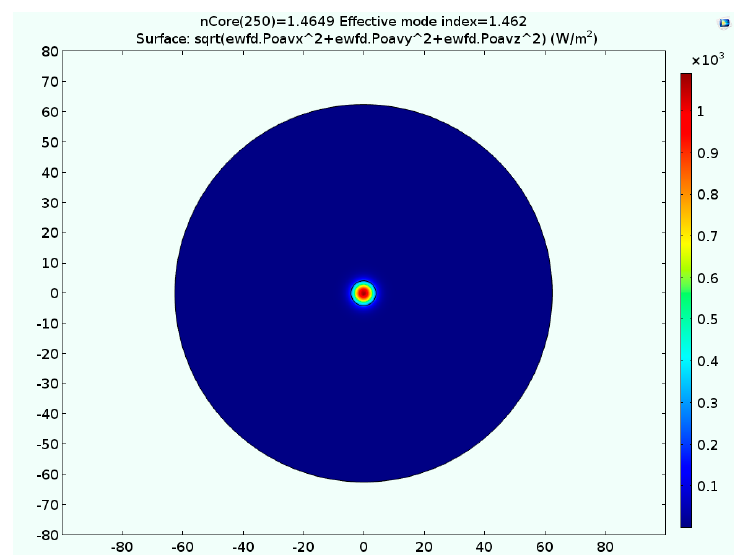
Figure 3. Visualization of the light intensity in the cross section of the SMF; the core’s index is 1.4649.